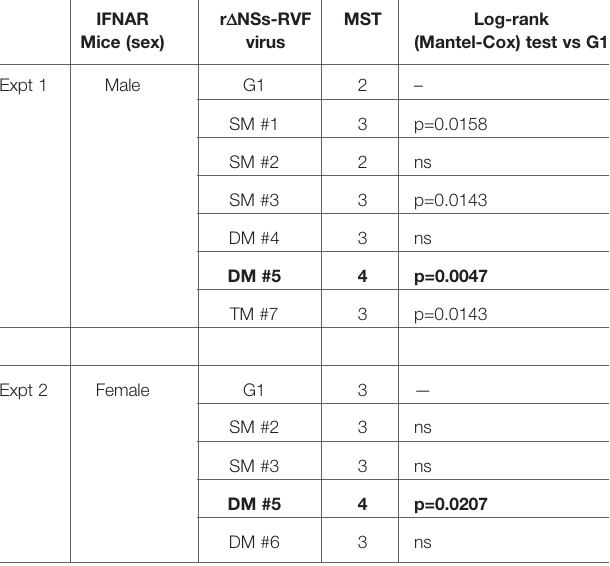
Experiments were carried out independently depending on the sex of the animals. Results were analyzed by the Log-Rank (Mantel-Cox) test. ns, non-signi fi cant differences. Results obtained with the rRVFV double mutant #5 are bold- typed to highlight their statistically signi fi cant